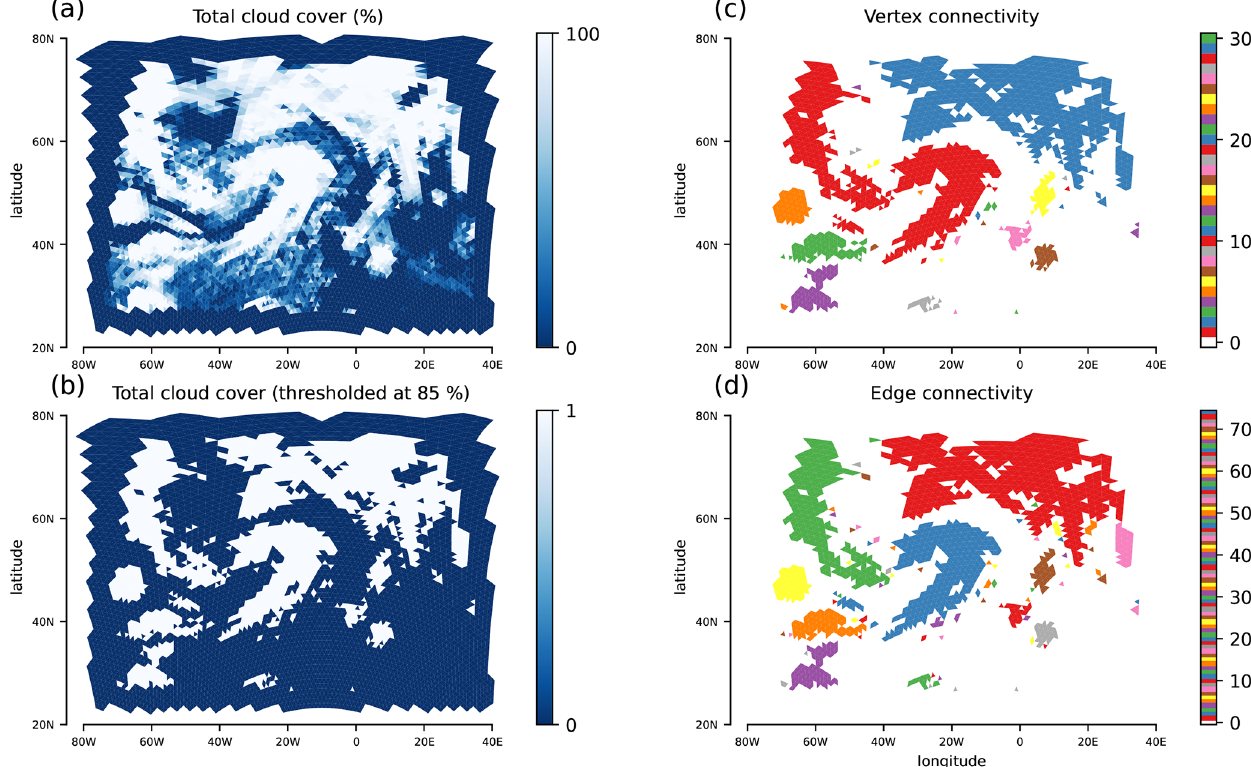
Figure 11. Application for total cloud cover from an ICON simulation with a limited-area grid over the North Atlantic. The triangular nature of the grid is visible. (a) Total cloud cover in percent, with 0 corresponding to cloud-free and 100 to completely overcast conditions. (b) Total cloud cover thresholded at 85%, with values above 85% set to 1 and values below set to 0. (c) Connected components for vertex connectivity, with components plotted in different colors. (d) Connected components for edge connectivity. In (c) and (d) , the connected components are ordered according to their sizes, starting with the largest component. Table 1. Size of the triangular grids used for benchmarking, as well as characteristics of the associated